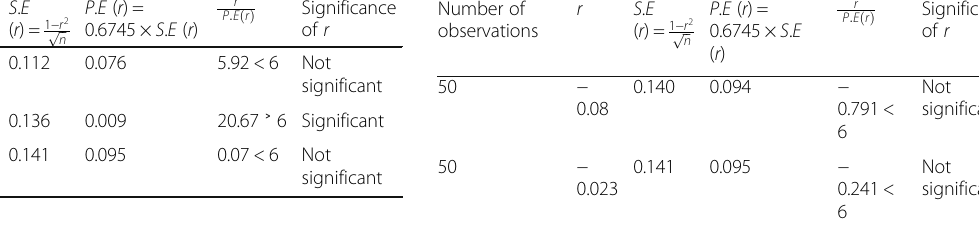
Table 6 Significance of correlation between Thumb, Index, and Ring finger per unit area for middle position Number of observations